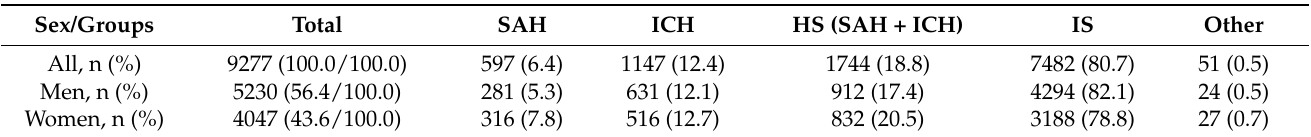
Table 1. Distribution of strokes by sex and stroke type. SAH: subarachnoid hemorrhage; ICH: intracerebral hemorrhage; IS: ischemic stroke.